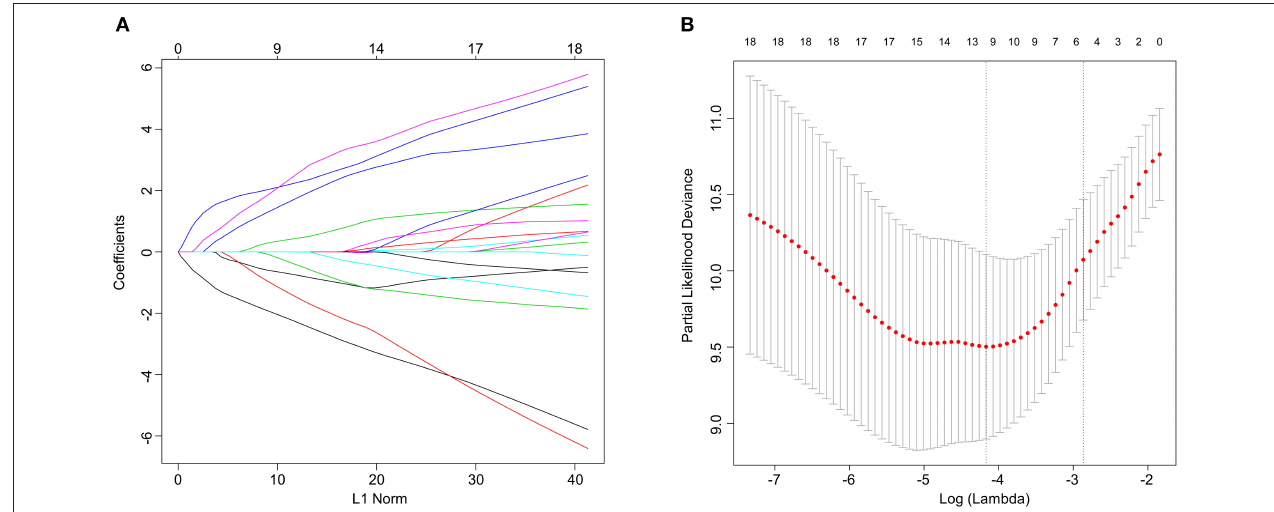
FIGURE 1 | Lasso Cox regression analysis. (A) Ten-time cross-validation for tuning parameter selection in the lasso model. (B) Lasso coefficient profiles of the 21 predictive proteins associated with BCR. A vertical line is drawn at the value selected by 10-fold cross-validation.